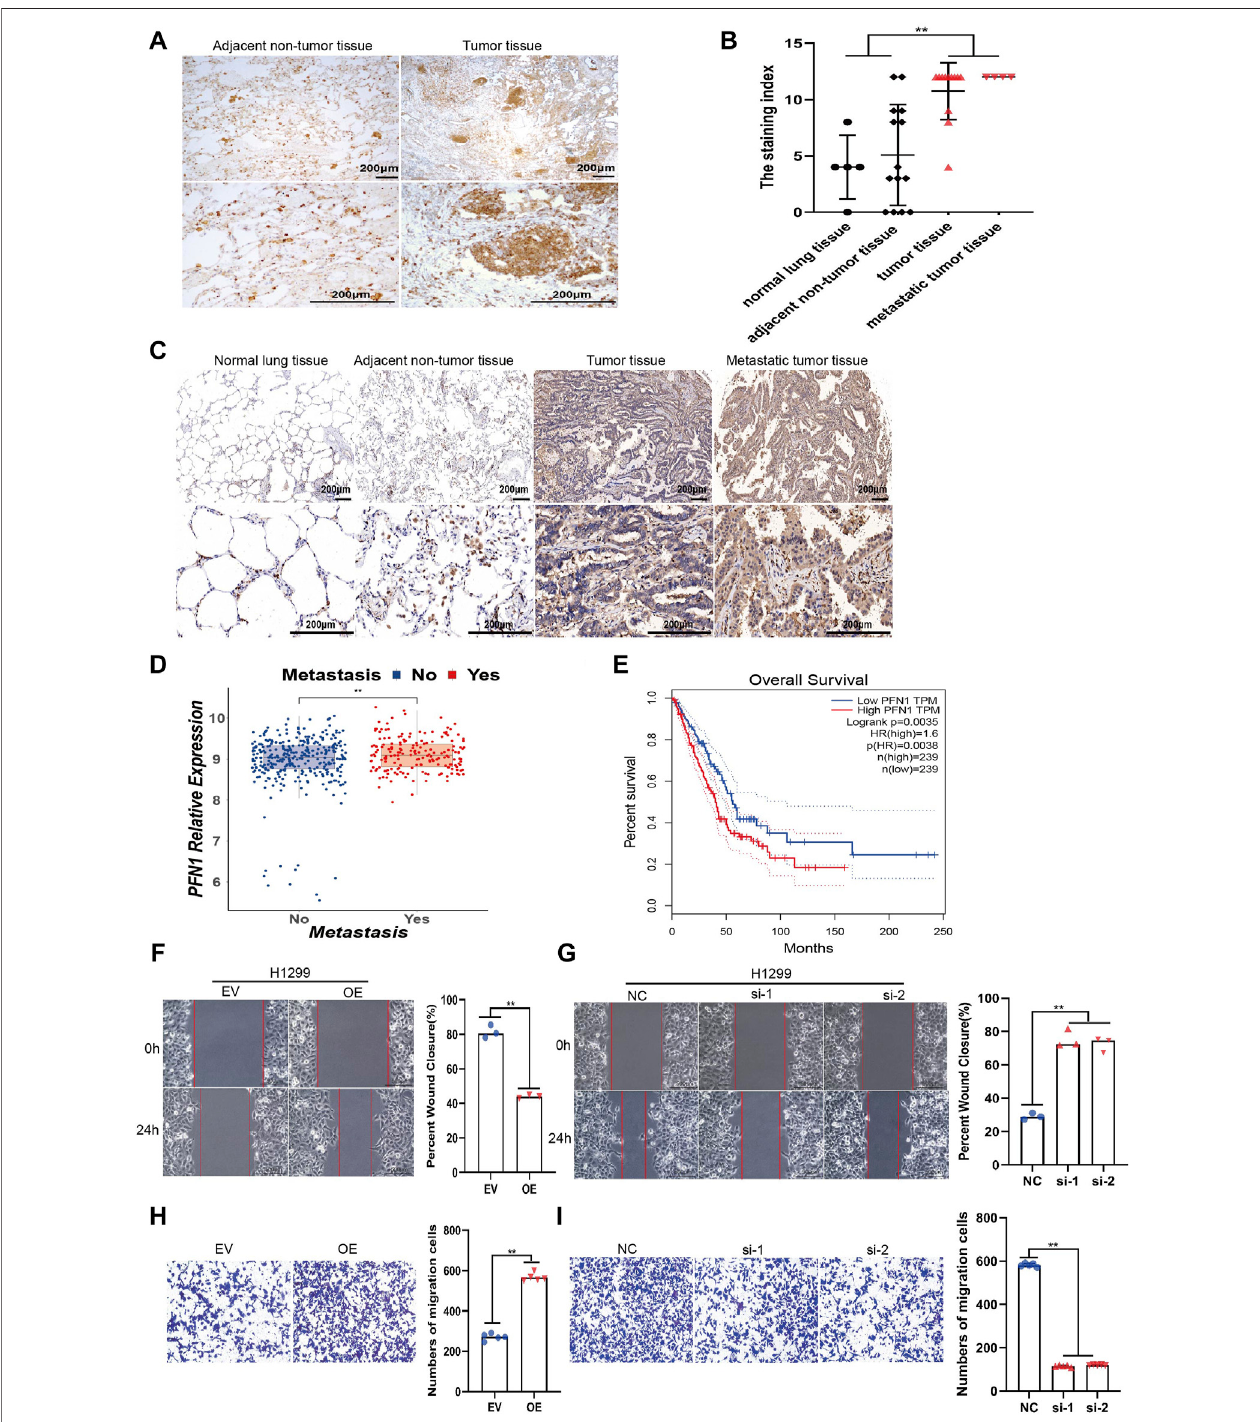
FIGURE1| PFN1iscorrelatedwithNSCLCmetastasisandcouldpromoteNSCLCcellmigration invitro . (A) RepresentativeIHCimagesofPFN1expressiononthe NSCLCtissues. (B) Thestainingindex of PFN1on the tissue chip. ** p < 0.01. (C) RepresentativeIHC images ofPFN1 expression on the tissue chip. (D) The expression of PFN1 in TCGA LUAD data. ** p < 0.01. (E) The Kaplan – Meier survival analysis of PFN1 in NSCLC patients. (Data source: TCGA LUAD dataset) (F,G) Wound healing assays conducted to evaluate the migration ability of PFN1 -overexpressing (F) and PFN1 knockdown (KD) (G) H1299 cells. ** p < 0.01; scale bar, 500 μ m. (H,I) Transwell migration assays conducted to evaluate the migration of PFN1 -overexpressing (H) and PFN1 KD (I) H1299 cells. ** p < 0.01; scale bar, 500 μ m. EV, empty vector; OE, PFN1 overexpression; NC, negative control; si-1/ 2, PFN1 siRNA1 1/2.